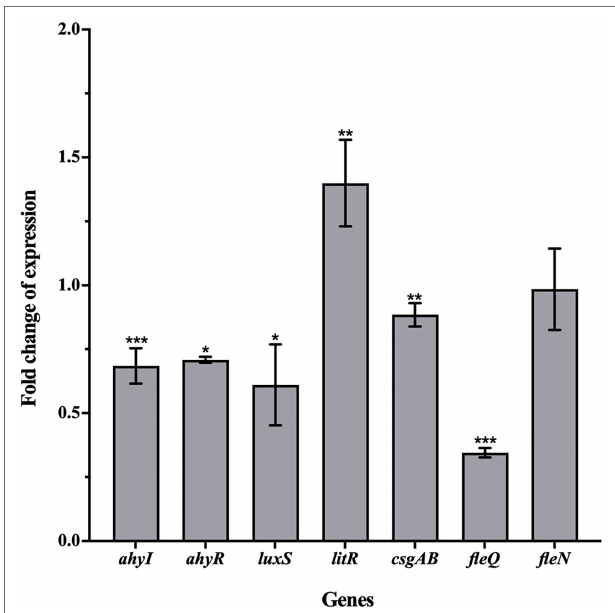
FIGURE 6 | Effect of esculetin at 100 μ g/ml on the expression of QS-related genes in A. hydrophila SHAe 115. Data are presented as the expression fold changes of mean ± SD of three independent experiments. * p < 0.05, ** p < 0.01, and *** p < 0.001 compared to the DMSO control group by t